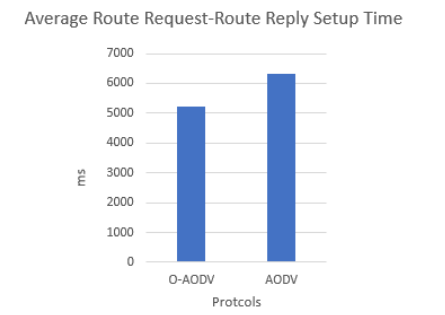
Figure 16. Average RREQ-RREP setup time.